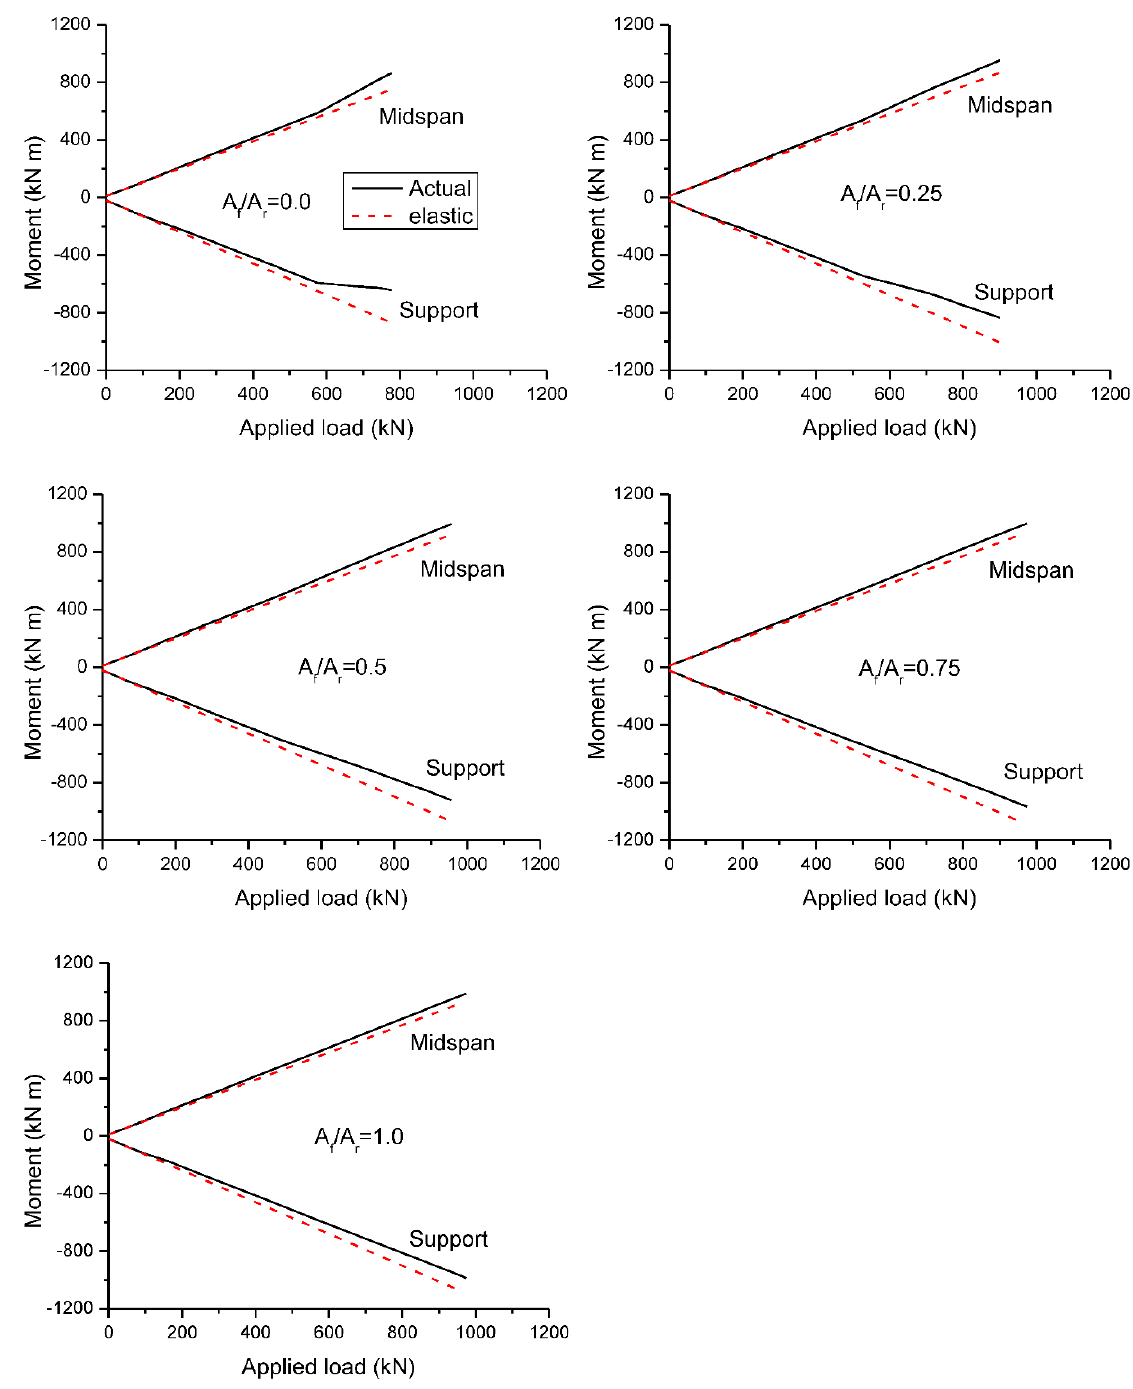
Figure 12. Load-moment behavior at symmetrical loading.